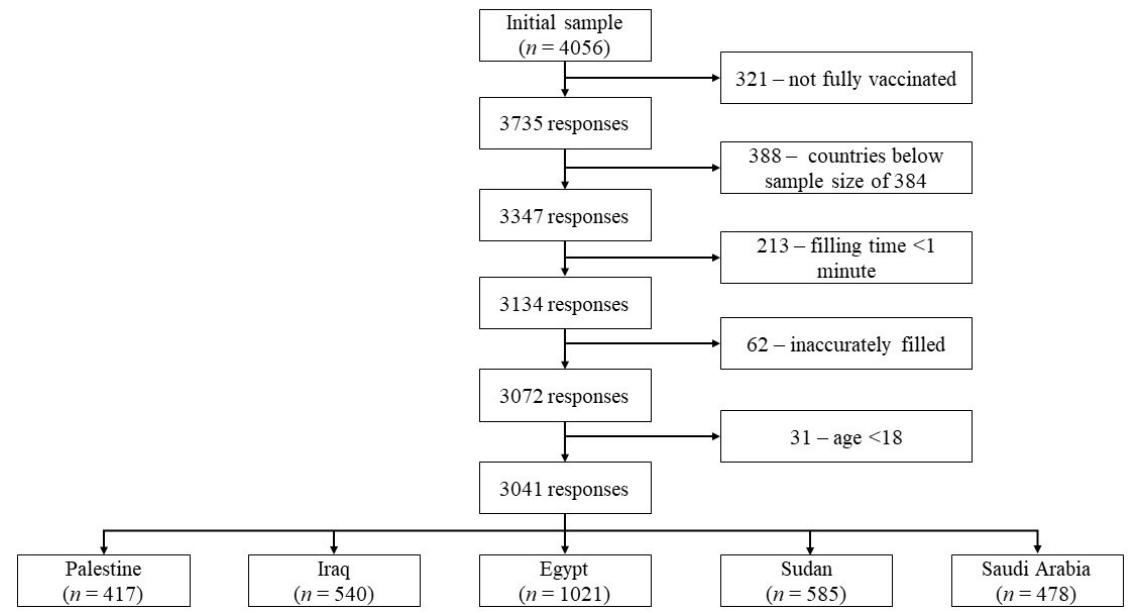
Figure 1. Inclusion/exclusion process for the responses. Table 1. Demographic characteristics of the respondents ( n = 3041), data reported as % ( n ). Parameter Statistics Age (years), median, interquartile range (min–max)